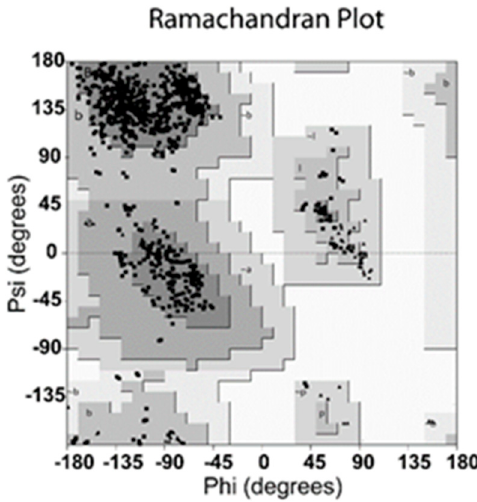
Figure 1. Ramachandran plot of optimized Streptococcus pneumoniae neuraminidase type A (NanA) protein system.